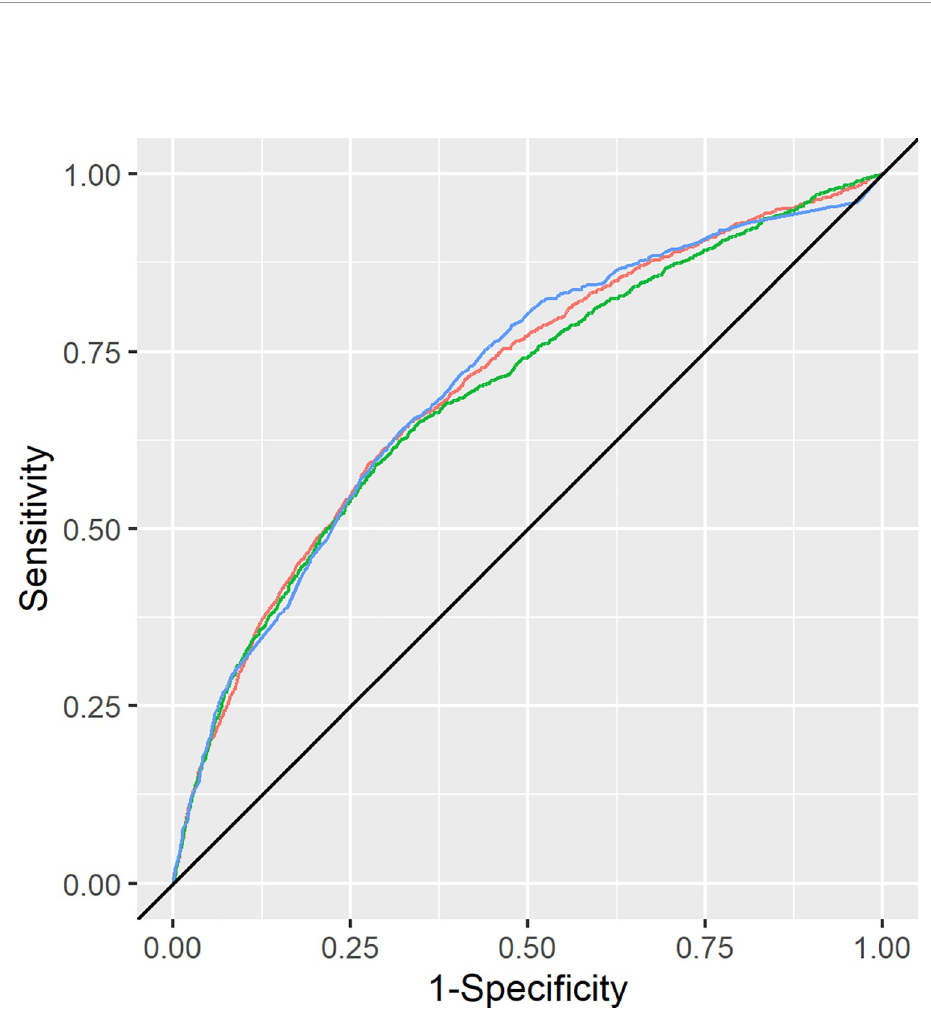
Fig 3. Receiver operating characteristic curves. (A) Red graph line = LACE+, Green = Epic model, Blue = SQLape 1 .